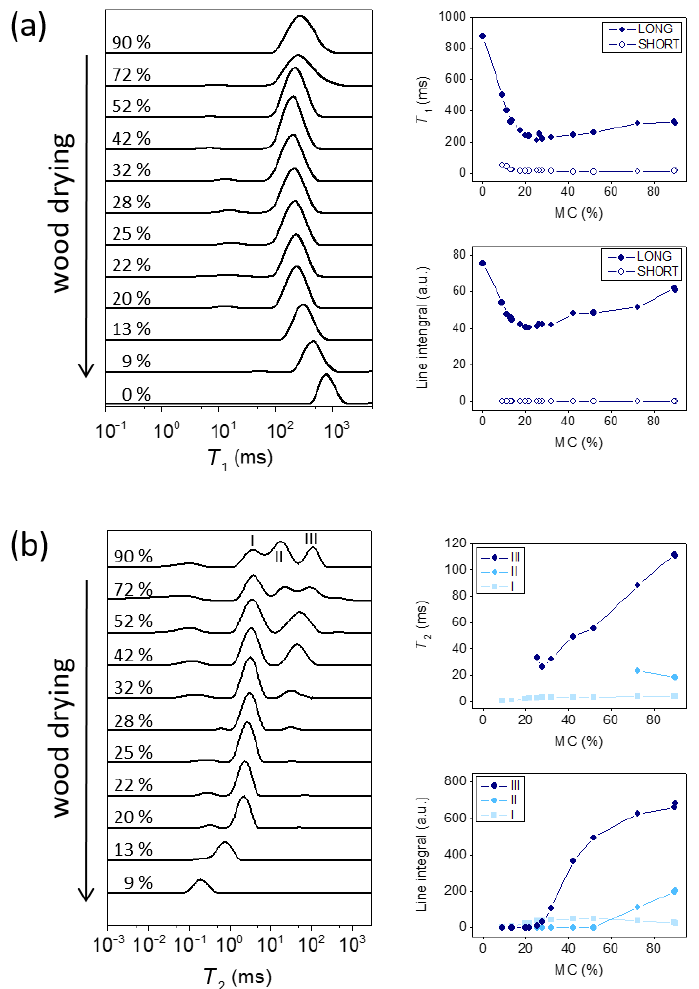
Figure 1. NMR relaxation time distributions together with the central relaxation time and the integrated intensities of the peaks at different MCs for the beech branchwood sample: ( a ) T 1 and ( b ) T 2 . The labels LONG and SHORT in the graphs in panel ( a ) correspond to the T 1 values of an intense peak in the range of hundreds of milliseconds (long) and to a small peak at few milliseconds (short), while the labels I, II and III in the graphs in panel ( b ) correspond to short, medium and long T 2 values of three distinct peaks in T 2 distributions.